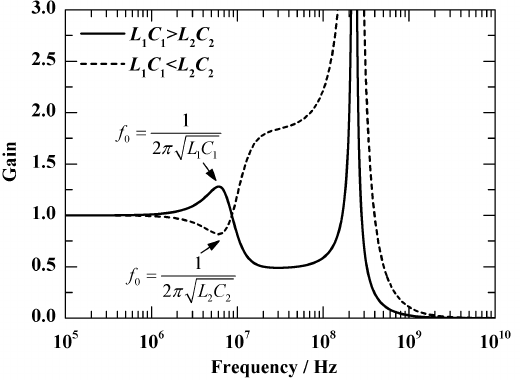
Figure 9. The influence of the resonance points of high– and low–voltage arms on the amplitude– frequency characteristics.